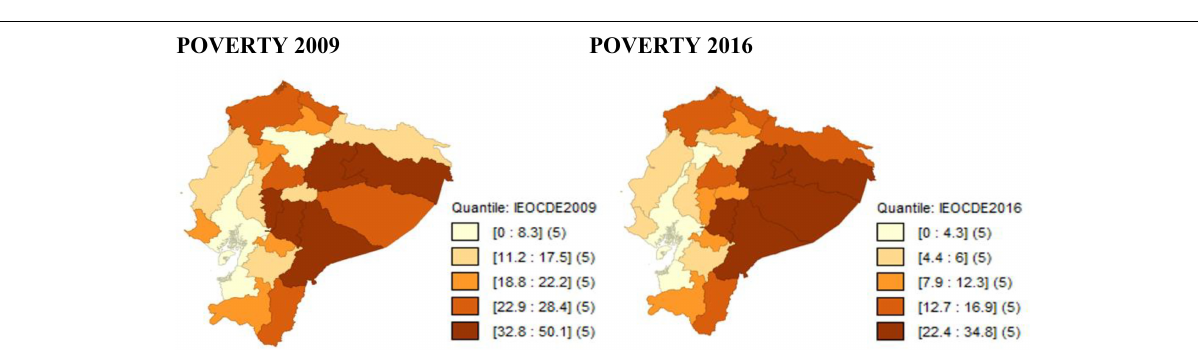
FIGURE 3 | Evolution of poverty by equivalent income with the IEOCDEM scale. Source: Own elaboration with data from ENEMDU 2009 and 2016.